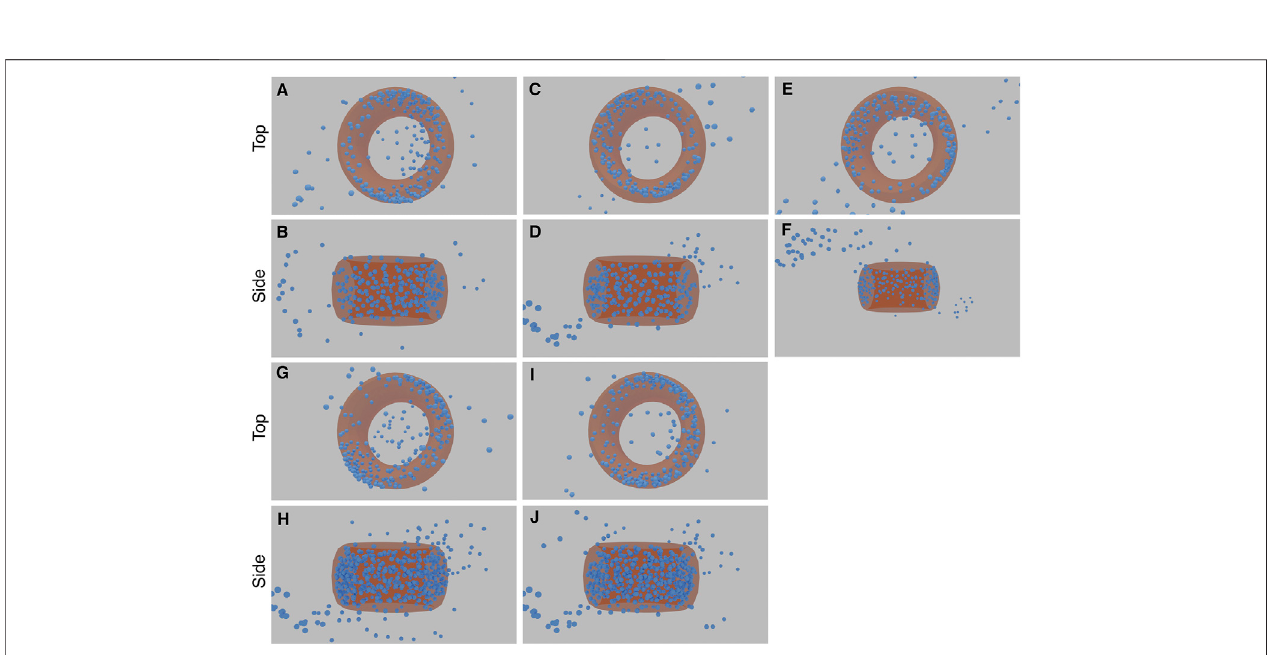
FIGURE 11 | Results of the fi ve STORM CEP152 experiments (each with a top and side view image pair). The fi rst experiment comprises image (A) and (B) , the secondexperiment (C) and (D) ,andsoforth.Thetorusstructurewithinthebluepointcloudishighlightedwithanorangering.See SupplementaryMaterialVideoS1, 2 for greater